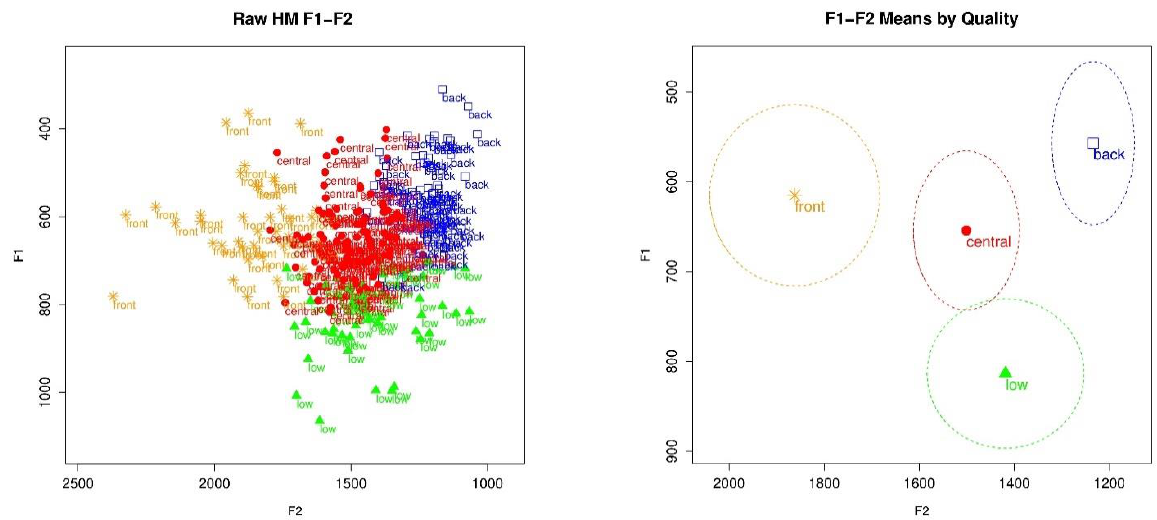
Figure 8. Vowel tokens ( left ) and means ( right ) in the sample (all speakers).